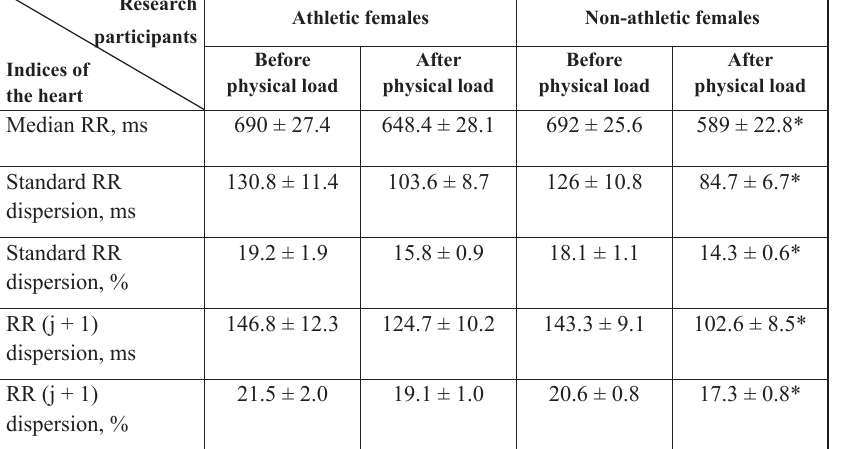
Table 1. Heart rate and variability before and after standardized phy- sical load while athletic and non-at- hletic female performed a mental work